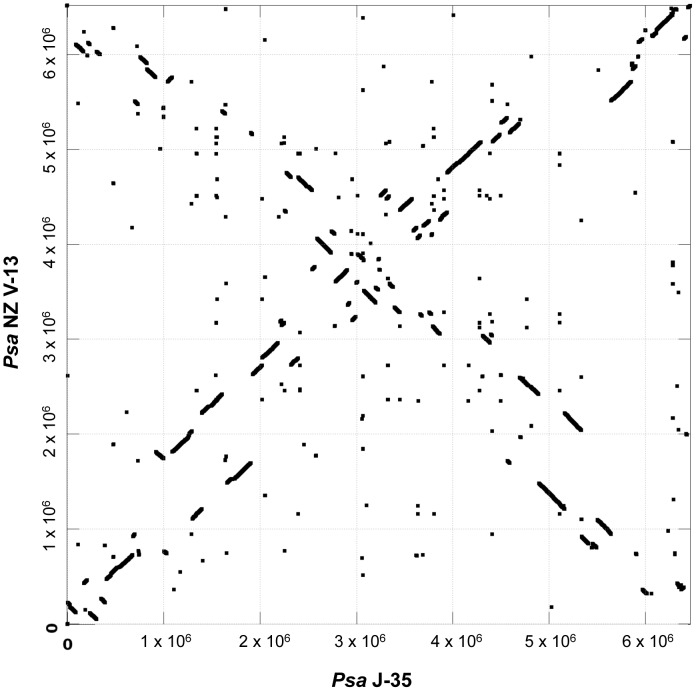
Synteny plot of Psa NZ V-13 and Psa J-35.MUMmer dotplot displaying stretches of conserved sequence between the genomes of Psa NZ V-13 and J-35 as lines with slope = 1. Inverted and translocated stretches of conserved sequence are displayed as lines with slope = −1.